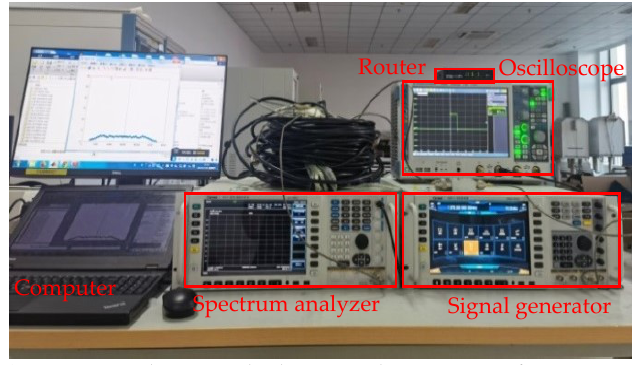
Figure 10. Hardware-in-the-loop simulation system for SF FM radar. Table 2. Experimental parameters.